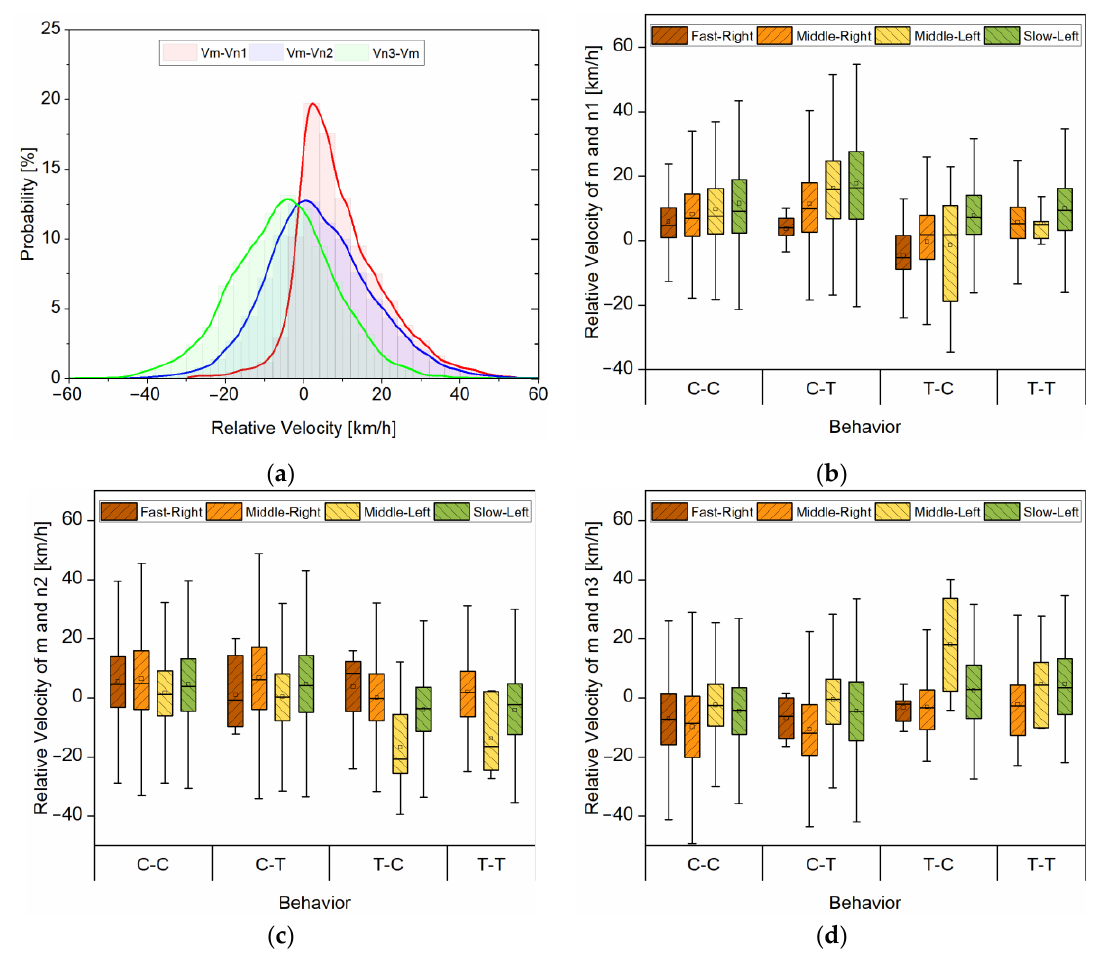
Figure 6. ( a ) Probability distribution of ∆ V; ( b ) ∆ V between m and n1; ( c ) ∆ V between m and n2; ( d ) ∆ V between m and